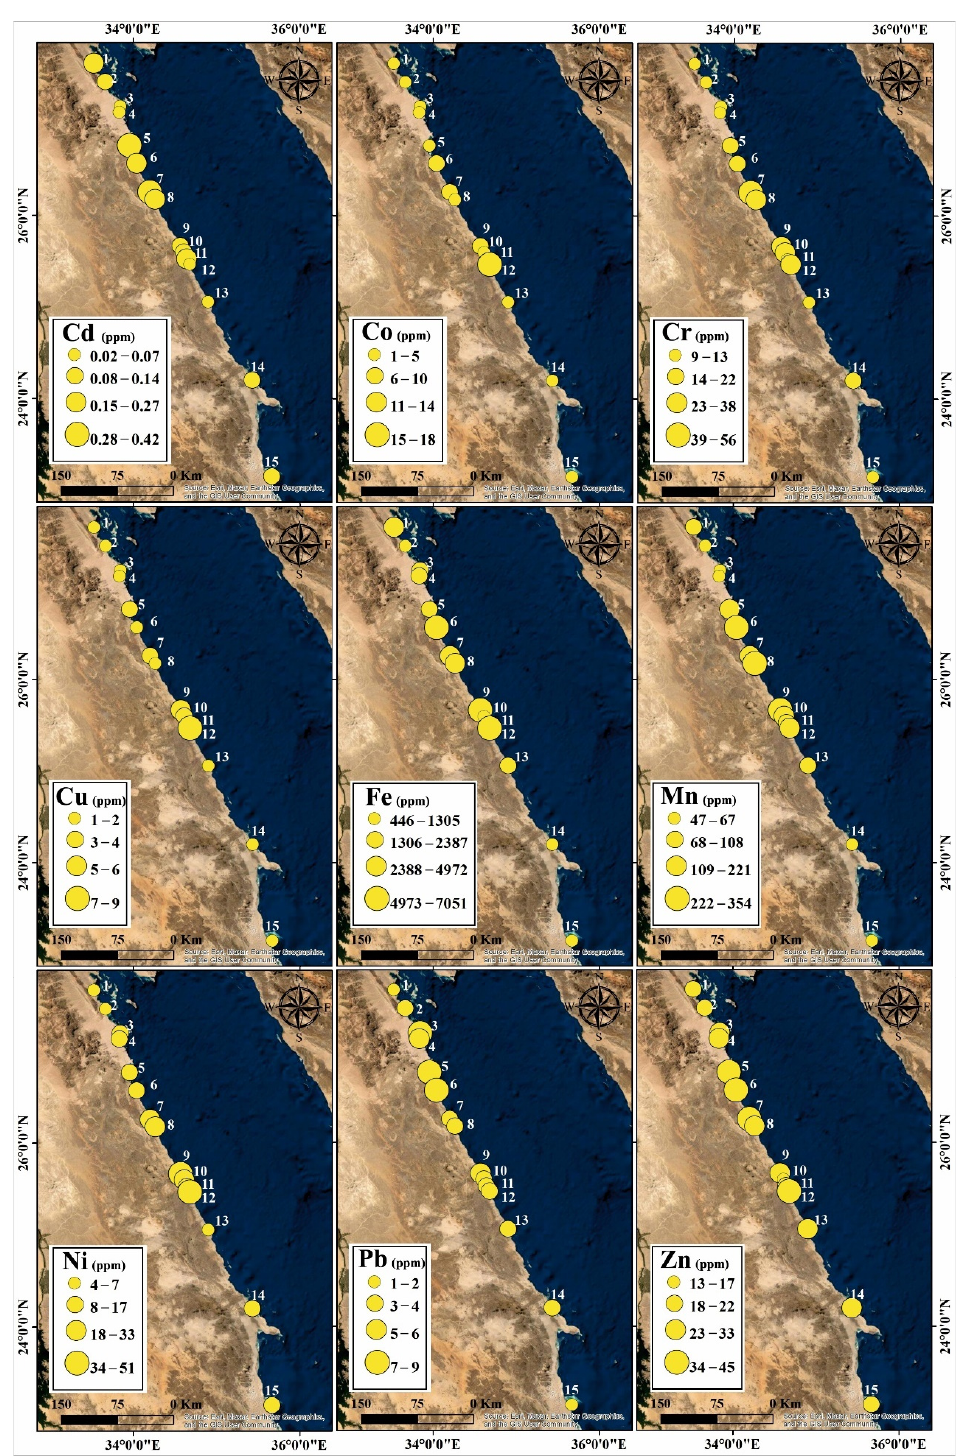
Figure 2. The distribution pattern of PTEs (As illustrated in legend, circles with varying radiuses represent different concentration